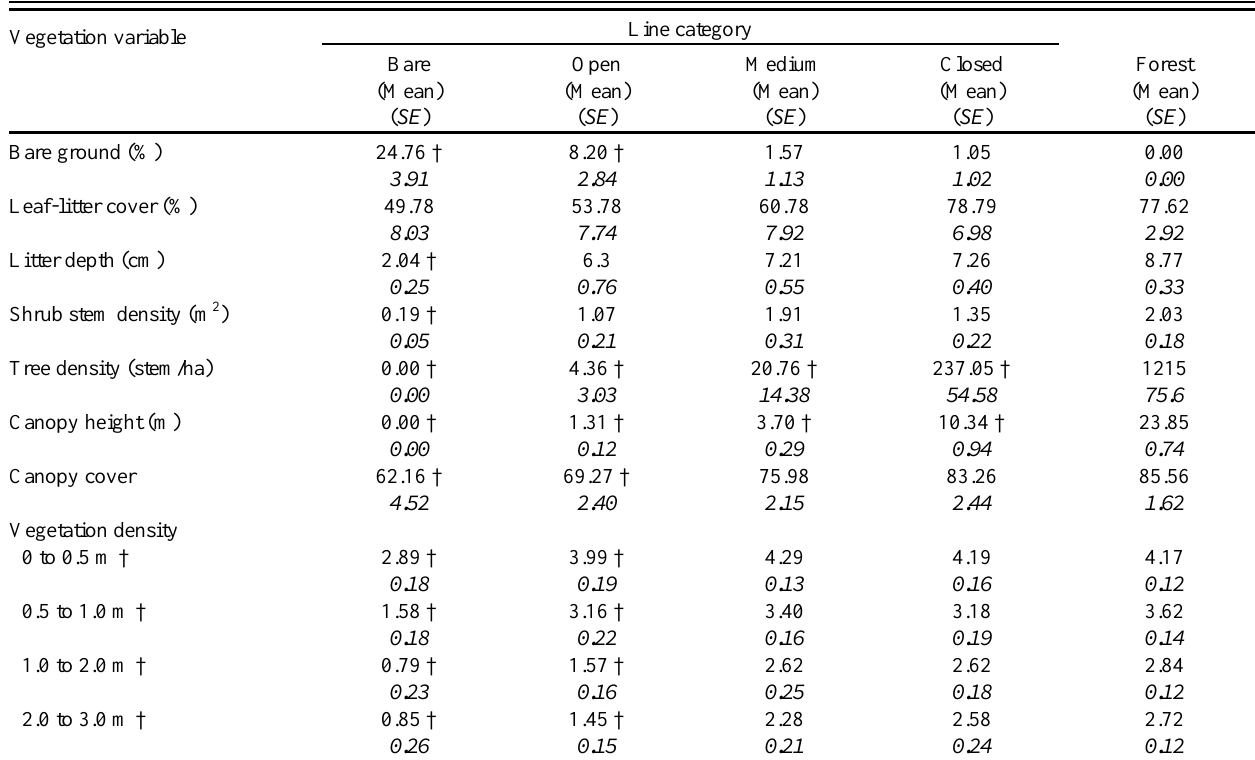
Table 5 . Description (means and standard errors of the means (SE) of selected vegetation variables by line type. Means of vegetation in the neighboring forest and landmark areas are included for reference. Asterisks indicate values that are significantly different from the forest interior ( a =